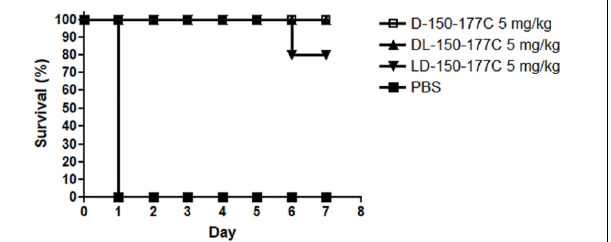
TABLE 3 | Enhancement of antimicrobial activity of buforin and lysin.